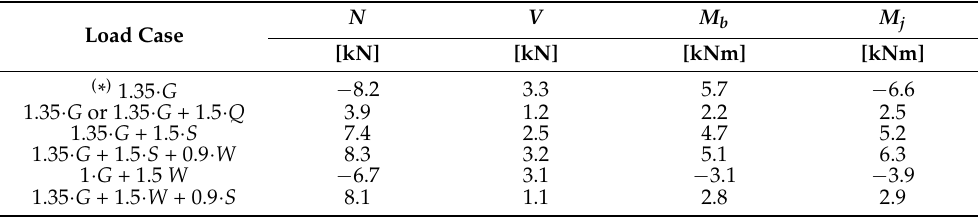
Table 2. Load cases and maximum internal forces deriving from structural